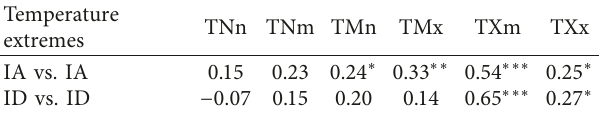
Table 6: Correlations and significance between temperature ex- treme changes and WD fluctuations at both interannual and interdecadal scales during 1961–2009 in the upper reach of the